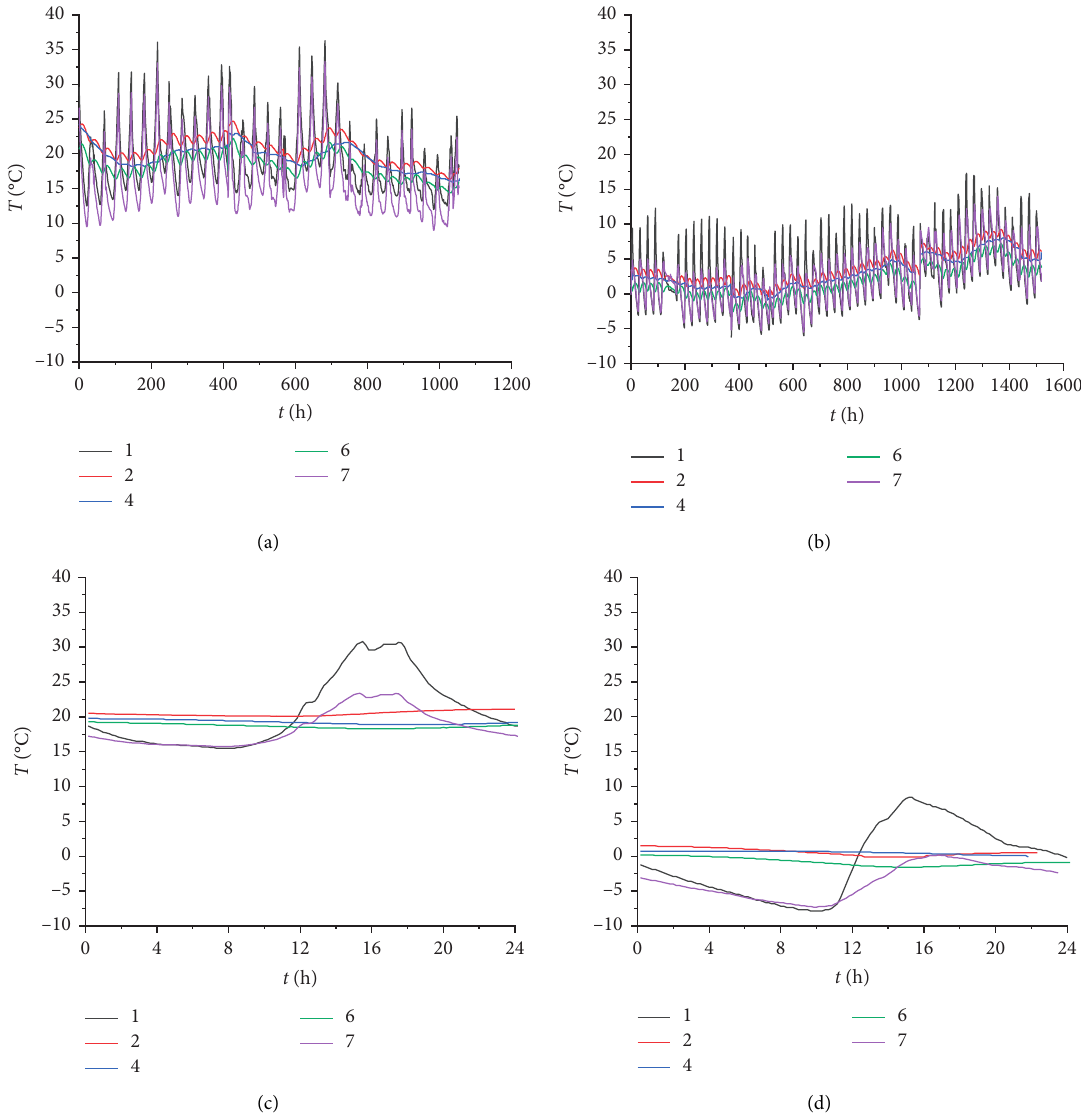
Figure 6: Temperature data obtained from measuring points. (a) Summer, (b) winter, (c) one day in summer, and (d) one day in winter.